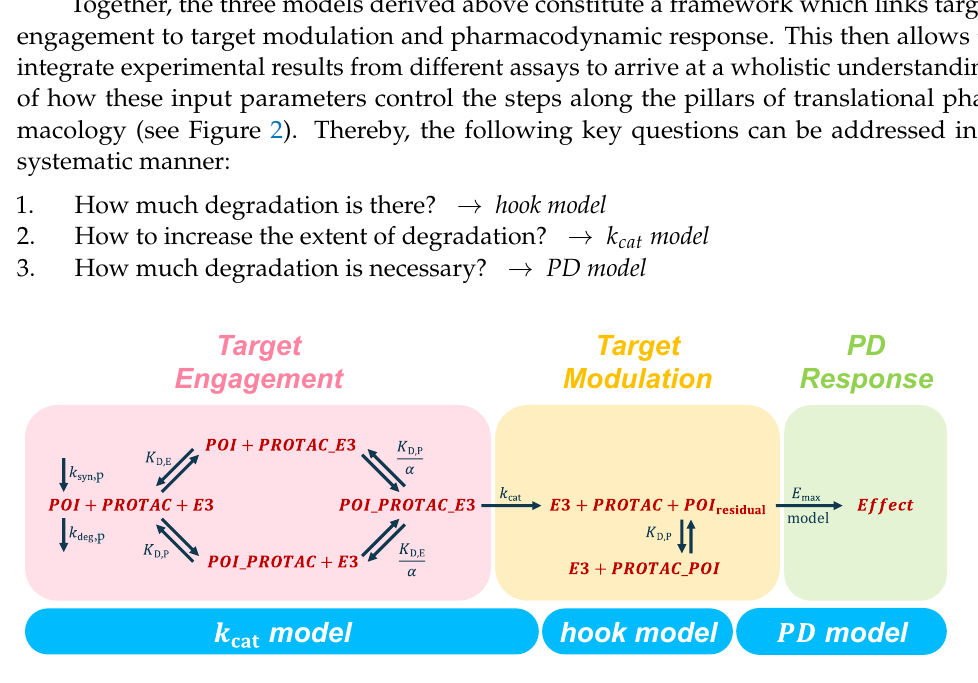
Figure 2. The pharmacodynamic modeling framework for PROTAC assessment and characteriza- tion consists of three models. (1) The k cat model links the biochemical parameters which govern target engagement to target degradation. (2) The hook model relates target degradation to PROTAC concentrations and incubation time. (3) The PD model integrates two mechanisms of target modulation, i.e., target degradation and target inhibition, and translates them to a downstream pharmacodynamic readout.